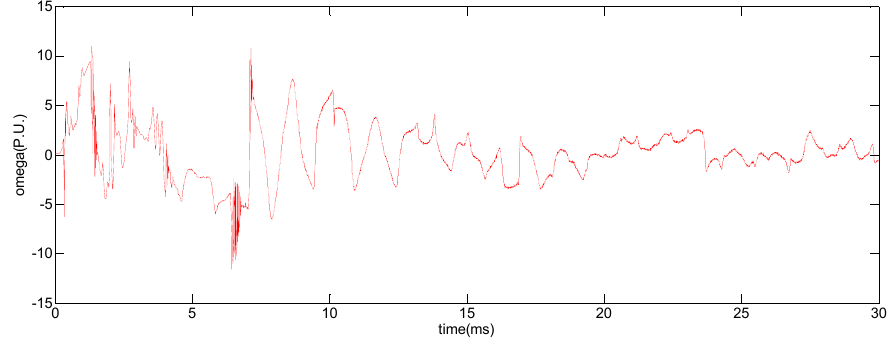
Figure 14. Adaptation performance of omega.